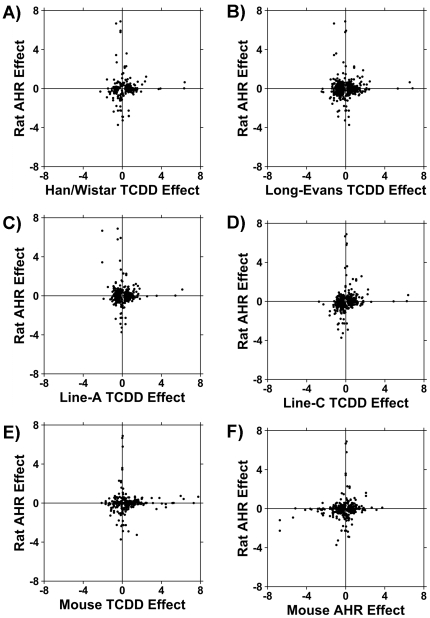
Comparison of Ahr Effect in Other Datasets.We next studied the set of genes whose mRNA levels were different between rats harbouring the wildtype Ahr allele (i.e. Long-Evans, Sprague-Dawley, and Line-C rats) and those harbouring the mutant Ahr
H/W allele (i.e. Han/Wistar and Line-A). We examined the response of these genes to a potent AHR ligand, TCDD, in four rat strains, in wildtype C57/BL6J mice, and in Ahr
−/− mice. A) The effects of the Ahr
H/W genotype in control rats were uncorrelated to the effects of TCDD in H/W rats (R = 0.034, P = 0.60) B) The basal effects of the Ahr
H/W genotype in rats were uncorrelated to those of TCDD in L-E rats (R = 0.036, P = 0.26) C) The basal effects of the Ahr
H/W genotype in rats were uncorrelated to those in Line-A rats (R = −0.064, P = 0.16) D) The basal effects of the Ahr
H/W genotype in rats were weakly, but statistically significantly, correlated to those in Line-C rats (R = 0.19, P = 3.3×10−6) E) The basal effects of the Ahr
H/W genotype in rats were uncorrelated to the effects of TCDD in C57BL/6J mice (R = 0.026, P = 0.65). F) The basal effects of the Ahr
H/W genotype in rats were weakly, but statistically significantly, correlated to the effects of genetic ablation of the Ahr locus in mice (R = 0.14, P = 0.0035).